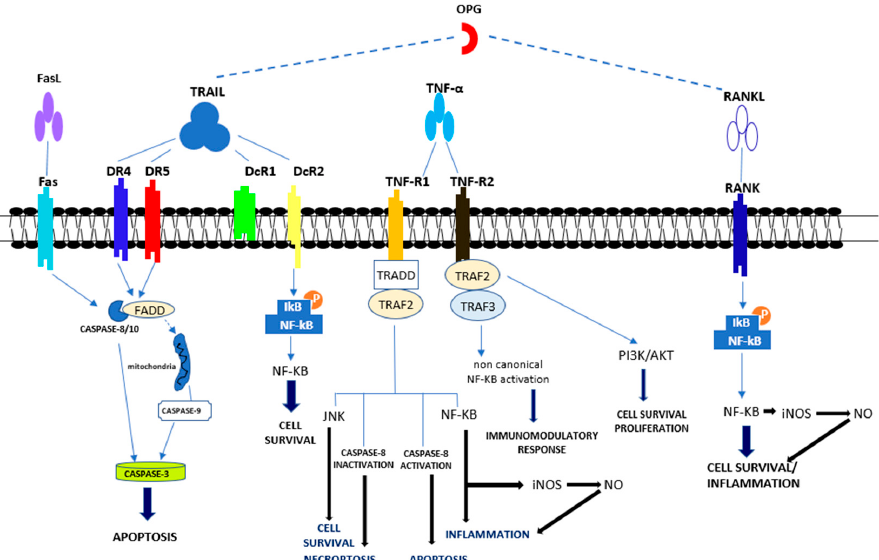
Figure 2. Overview of apoptotic and non-apoptotic signaling by the Tumor Necrosis Factor Receptor (TNFR)s. Apoptotic signal included the activation of caspase-8, -3 and -9. Pro-survival signal occurred through the activation of NF- κ B, JNK, PI3K/AKT Abbreviations: Fas ligand (FasL); Tumor necrosis factor (TNF)-related apoptosis-inducing ligand (TRAIL); Death receptor 4 (DR4); Death receptor 5 (DR5); Decoy receptor 1 (DcR1); Decoy receptor 2 (DcR2); Tumor necrosis factor α (TNF α ); Tumor necrosis factor receptor 1 (TNF-R1); Tumor necrosis factor receptor 2 (TNF-R2); Receptor activator of NF- κ B (RANK) ligand (RANKL); Receptor activator of NF- κ B (RANK); FAS-associated death domain (FADD); Tumor necrosis factor receptor type 1-associated death domain (TRADD); TNF receptor-associated factor 2 (TRAF2); TNF receptor-associated factor 3 (TRAF3); c-Jun N-terminal Kinase (JNK); Nuclear factor- κ B (NF- κ B); PhosphatidylInositol 3-kinase (PI3K); Protein kinase B